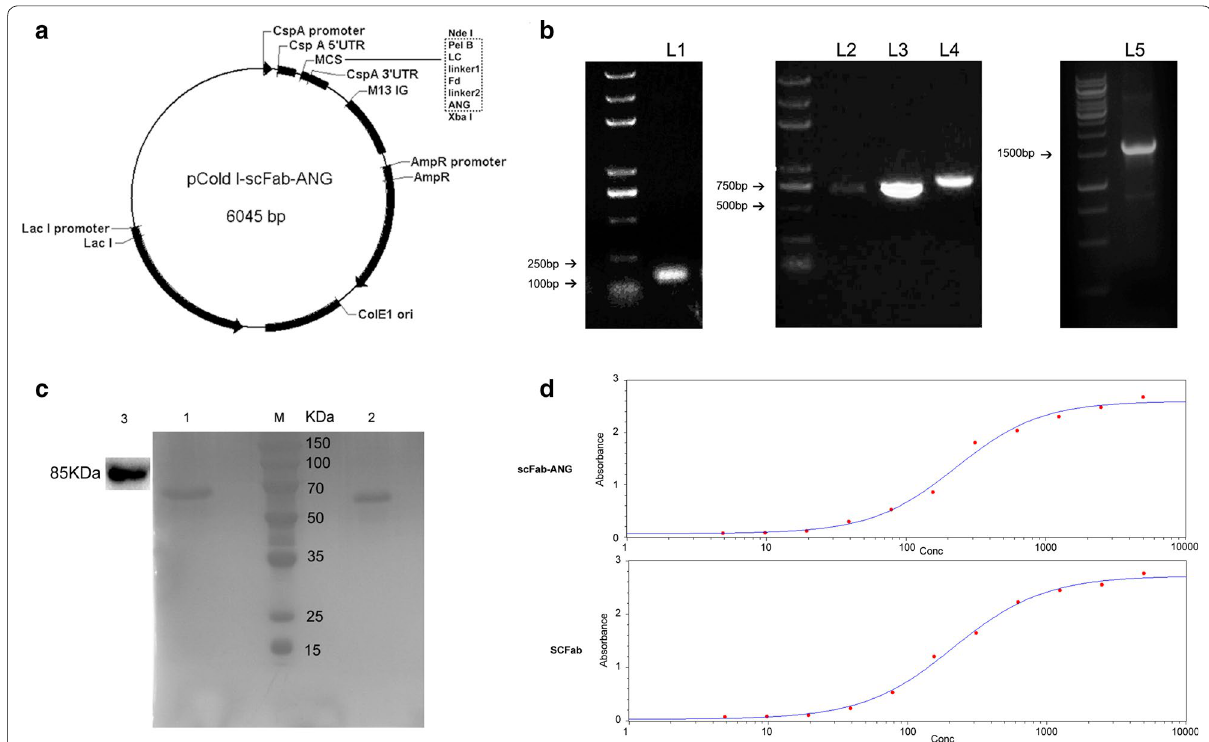
Fig. 1 Construction of the scFab-ANG vector and identification of the activity of the fusion protein. a Illustration of vector pCold I-scFab-ANG. b Agarose gel electrophoresis of nucleic acid amplified by PCR, L1, L2, L3, L4, and L5 correspond to the gene segments of ANG, light chain, Fd domain of heavy chain, Fd-ANG and scFab, respectively. c SDS-PAGE gel electrophoresis of scFab-ANG and scFab proteins. Lane 1 is scFab-ANG, Lane 2 is scFab, Lane 3 is western blotting determination using total protein of hCMEC/D3 and LRP-1 molecular weight was about 85 kDa. d 4-parameter equation of indirect ELISA of